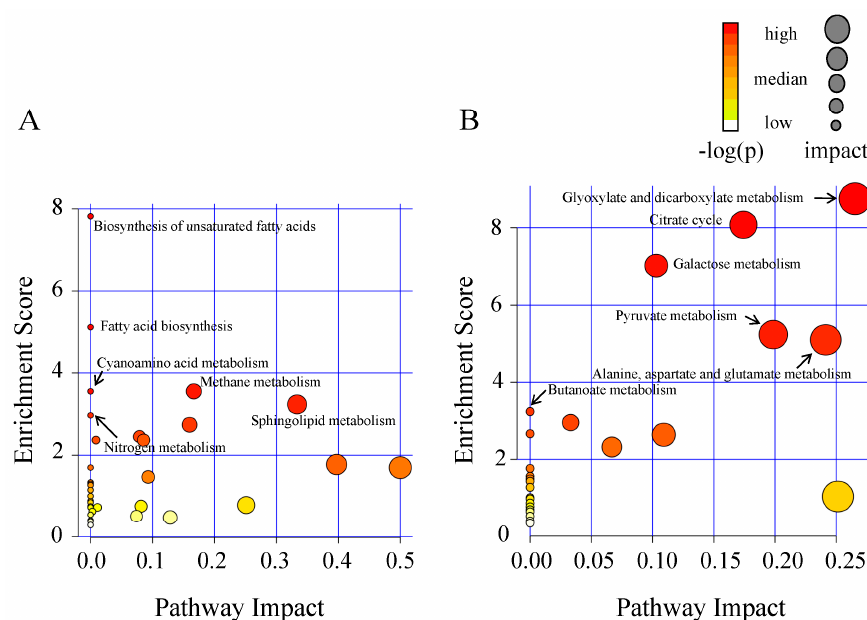
Figure 3. Schematic of the metabolome based on the metabolic pathways mapped with the A. germari infection associated differential metabolites. The analysis was performed using MetaboAnalyst software. ( A ) Pathway assignment of differential metabolites in bark tissues; ( B ) pathway assignment of differential metabolites in xylem tisseus.